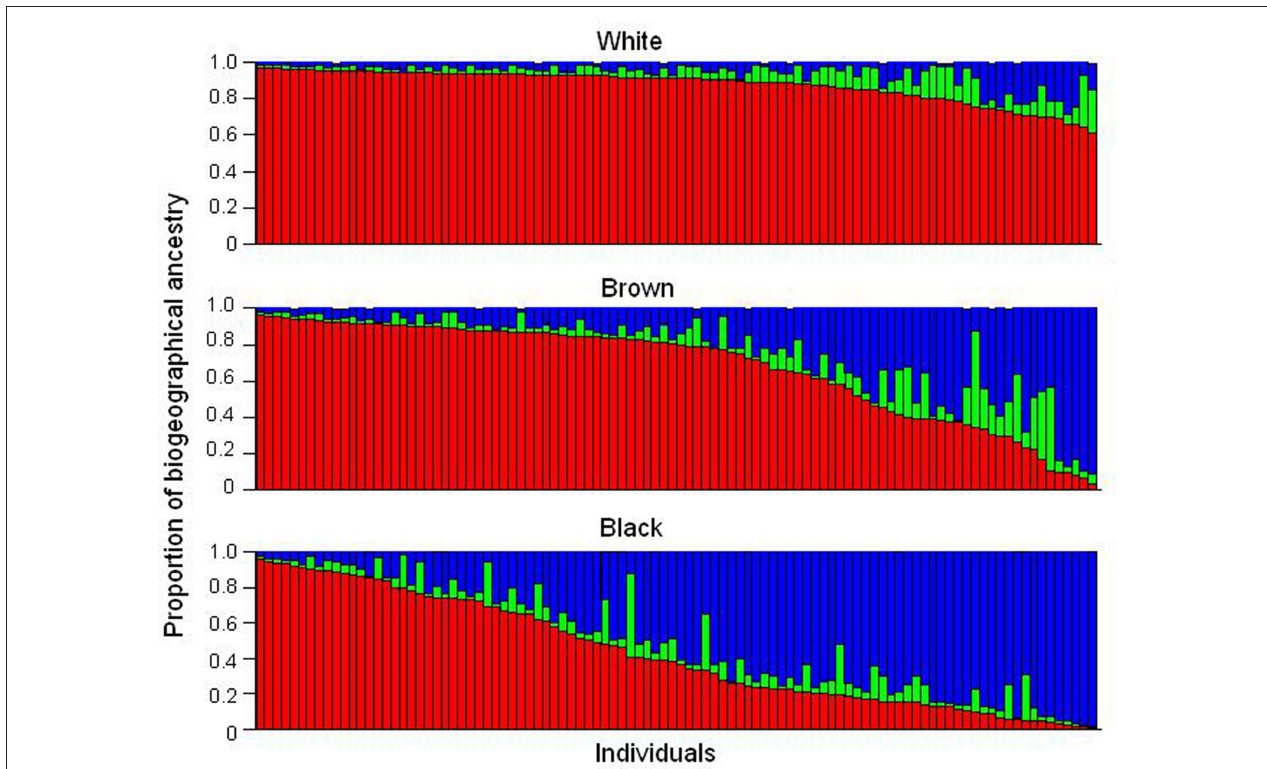
adopted by the Brazilian Census. Each individual is represented by a vertical line, which is partitioned in three colored segments corresponding to the individual’s estimated membership proportion in the African (blue), Amerindian (green), and European (red) clusters. Data from Suarez-Kurtz et al.